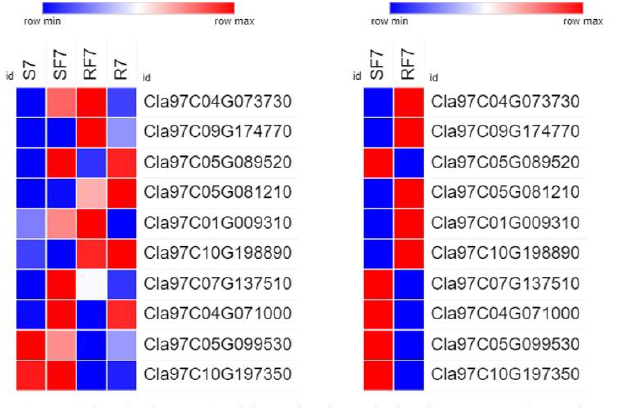
Figure 10. Relative expressions of 10 candidate genes in different samples by RT-qPCR. Note: S7, Susceptible cultivar + mock-inoculation control (H 2 O 2 ), 7 dpi (7 days post inoculation); R7, Resistant cultivar + mock-inoculation control (H 2 O 2 ), 7 dpi (7 days post inoculation); SF7, Susceptible cultivar + FON, 7 dpi (7 days post inoculation); RF7, Resistant cultivar + FON, 7 dpi (7 days post inoculation). Three biological replicates per samples were analyzed.